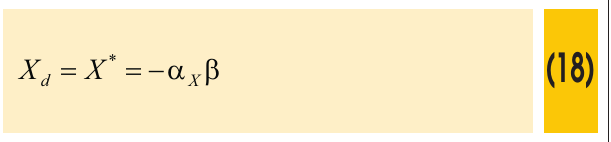
Figure 4 – Variation on the random variables sensitivity regarding to failure probability of the beams before